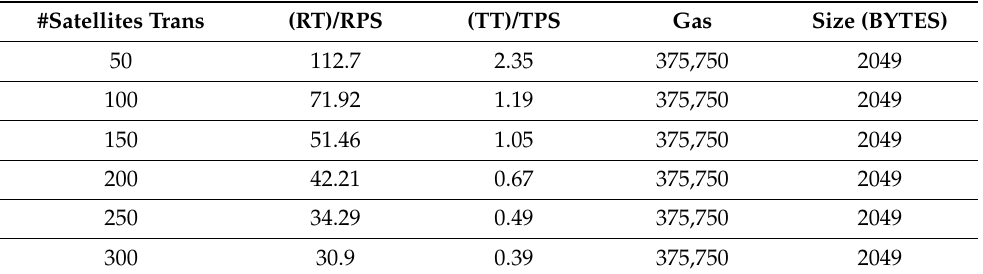
Table 6. Results of the impact of the transactional data size 3049 bytes on RT, and TT according to the number of satellite transactions.